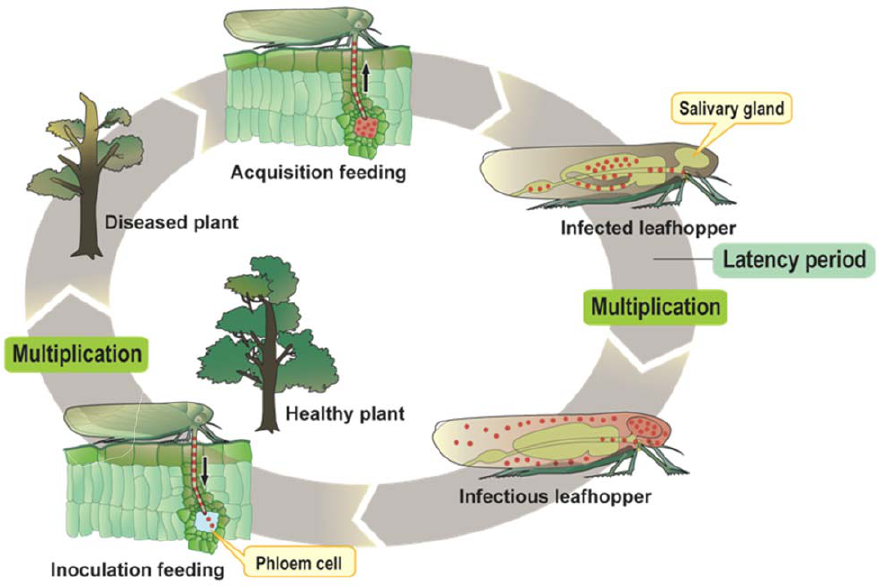
Figure 1. Life cycle of phytoplasmas. Phytoplasma is shown as a red dot. Phytoplasmas are unique biologically in that they can parasitise a diverse range of hosts, including plants (Kingdom Plantae) and insects (Kingdom Animalia). Phytoplasmas can reside endocellularly within the plant phloem and feeding insects (leafhoppers), and are spread among plants by insects.